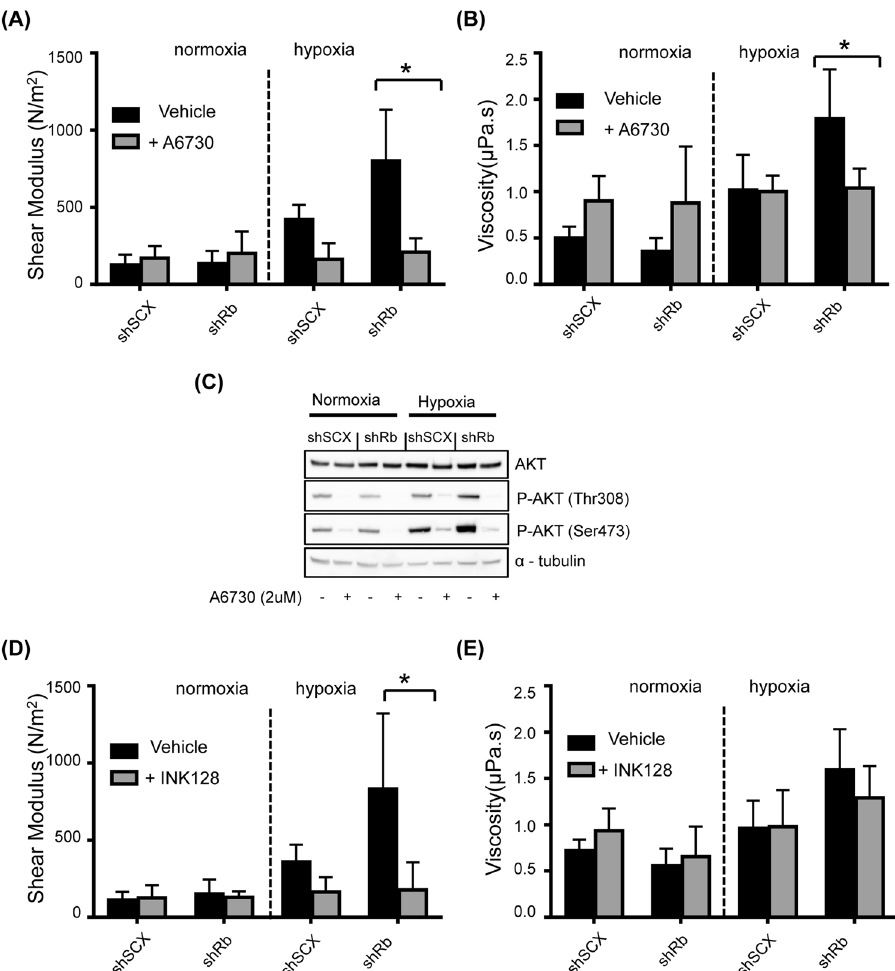
Figure 4. Inhibiting either the AKT or MTOR pathways alters the mechanical properties of LNCaP cells. Variation in ( A ) shear modulus or ( B ) viscosity of shRb and shSCX LNCaP cells after exposure to 72 h of hypoxia or normoxia and treated with or without 2 μ M A6730. ( C ) Immunoblots of LNCaP shRb and shSCX whole cell lysates after exposure to 72 h of hypoxia or normoxia and treated with or without 2 μ M A6730. Blots were probed with antibodies against AKT, phospho-AKT (Thr308), phospho-AKT (Ser473) and α -tubulin. Samples were derived from the same experiment and blots were processed in parallel. Complete blot images are shown in Supplementary Information File 1, Figure S1. Variation in ( D ) shear modulus or ( E ) viscosity of shRb and shSCX LNCaP cells after exposure to 72 h of hypoxia or normoxia and treated with or without 10 nM INK128. For A , B , D and E , experiments were conducted in triplicate (n = 3) and ten cells were examined in each experiment. Error bars represent ± S.D. * p <